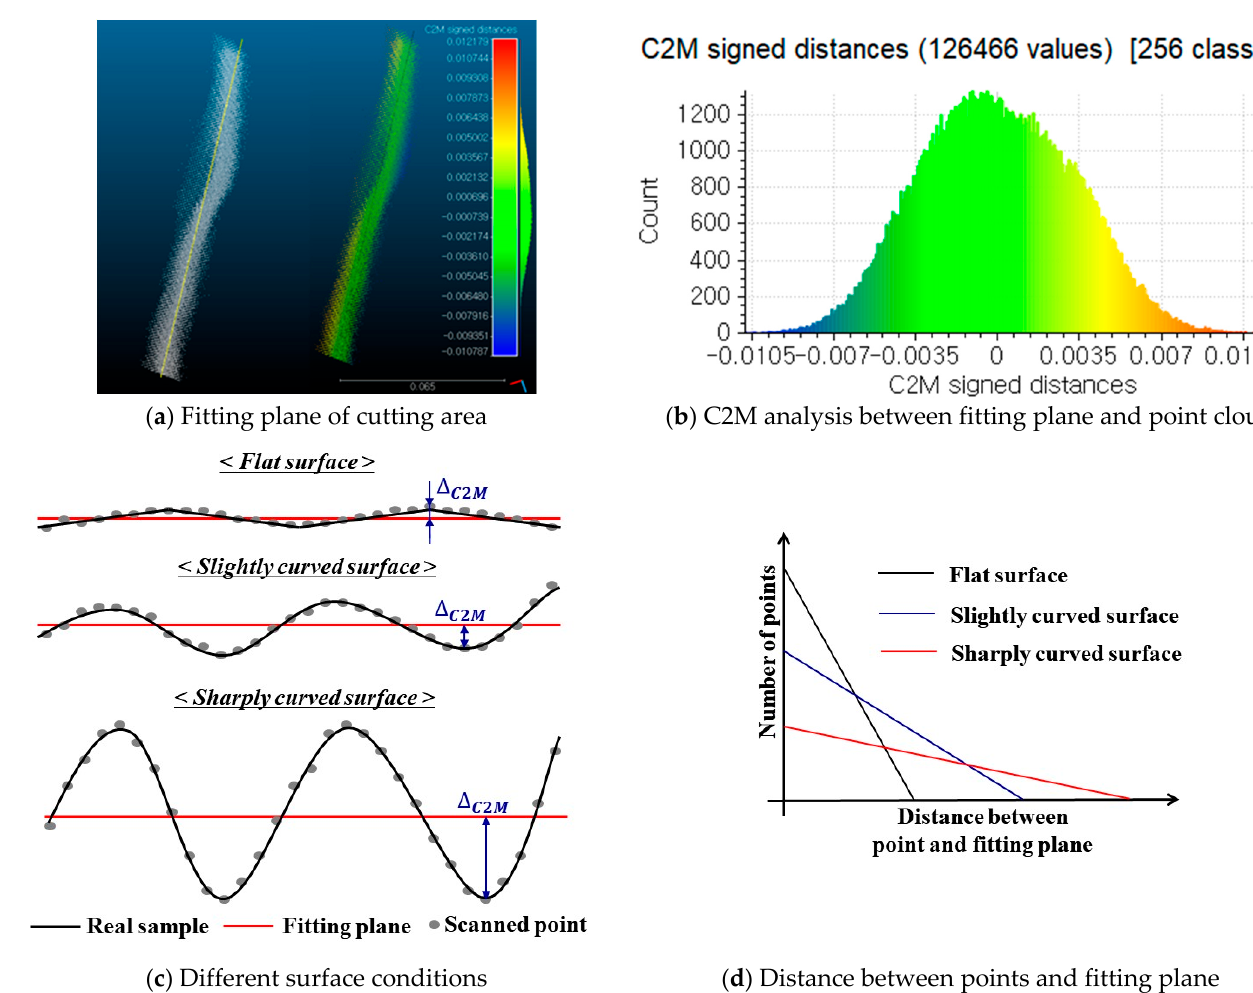
Figure 6. Cloud compare analysis using fitting plane.